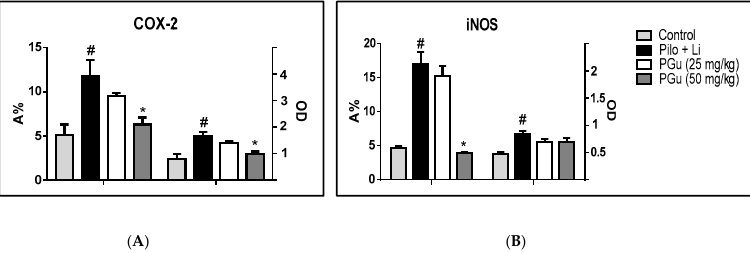
Figure 5. Quantitative image analysis for COX-2 ( A ) and iNOS ( B ) immunohistochemical staining expressed as optical densities (OD) across 7 different fields for each rat section. LiCl was injected at a dose of 3 mEq/kg b.w. i.p. After 24 h, the animals were injected with pilocarpine hydrochloride at a dose of 30 mg/kg b.w. PGu was given doses of 25 and 50 mg/kg twice and the second dose was given 1 h before pilocarpine. Data are presented as mean ± S.E. The superscripts # and * indicate significance in relation to the control and pilocarpine + lithium-treated groups, respectively, at p < 0.05.